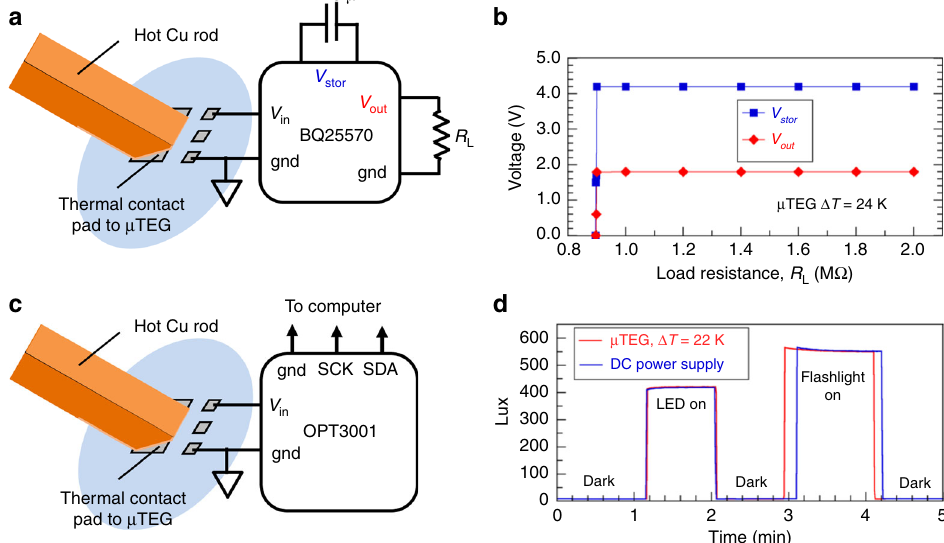
Fig. 4 Performance of integrated circuits energized by a harvest mode µ TEG. a Illustration of the connections between a hot Cu rod, thermal contact pad, µ TEG electrical contacts, and a BQ25570 power management integrated circuit (PMIC) with a 4.8 µ F storage capacitor and a load resistance R output. b PMIC steady-state storage voltage (blue squares) and output voltage (red diamonds) vs. R L , µ TEG operating from Δ T = 24 K. c Illustration of the connections between a hot Cu rod, thermal contact pad, µ TEG electrical contacts, and an OPT3001 ambient light sensor. d Ambient light intensity sensed by the OPT3001 in response to a red light-emitting diode (LED) and a white fl ashlight. The red line is the signal when energized directly by the µ TEG operating from Δ T = 22 K. The blue line is the signal when energized by a standard DC